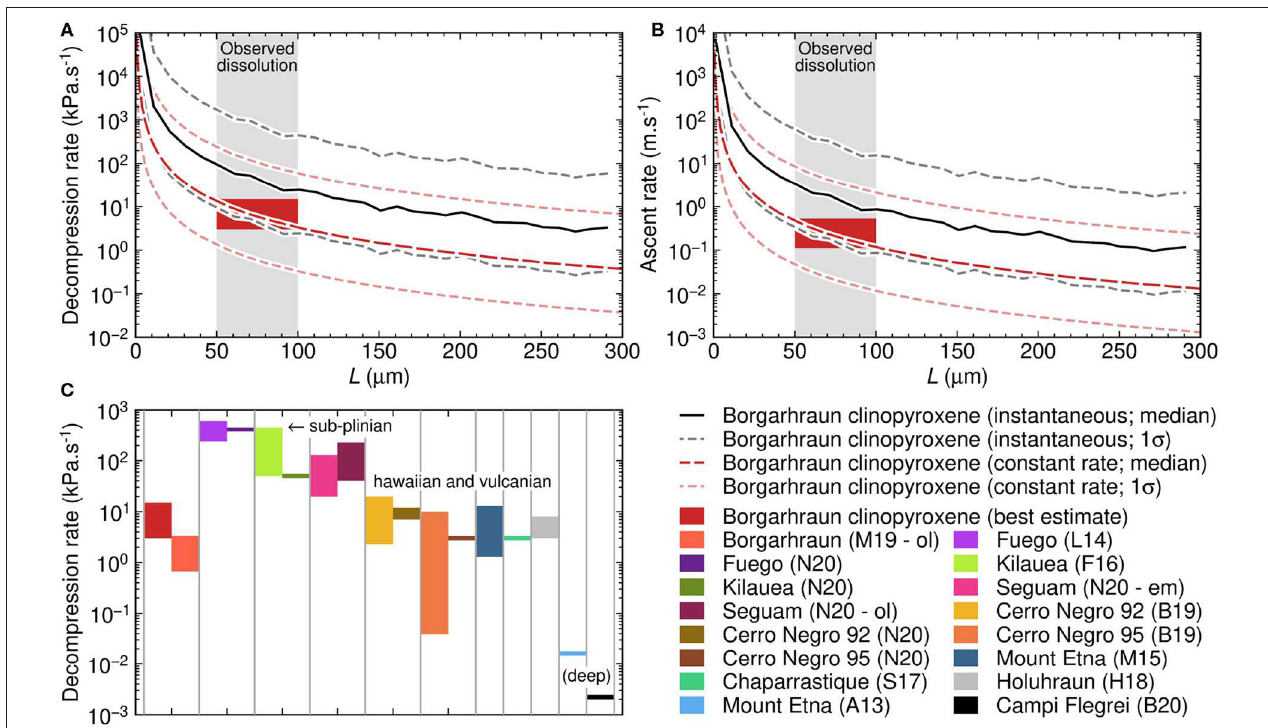
FIGURE 9 | Magma decompression and ascent rates in basaltic systems. (A,B) Magma decompression and ascent rates are shown as functions of dissolution length for nodule clinopyroxene cores dissolving into the Borgarhraun matrix glass in (A,B) , respectively. Solid black lines show decompression and ascent rates calculated using the dissolution times shown in Figure 8 . These decompression and ascent rates represent mean values calculated with the simplifying assumption that all dissolution took place at the surface following instantaneous ascent. Dashed red lines show decompression and ascent rates calculated assuming that magma decompression and ascent took place at a constant rate from onset of clinopyroxene dissolution. The vertical gray bar represents the range of dissolution lengths identified from QEMSCAN and BSE images ( Figures 2 , 3 ) that constrain our best estimates of magma decompression and ascent rates. (C) Literature estimates of magma decompression rate from basaltic systems compared with our best estimate for the Borgarhraun eruption. Methods and sources of decompression rate estimates are as follows: M19, olivine diffusion for the Borgarhraun eruption by Mutch et al. (2019b); L14, diffusive volatile loss from embayments for the 1974 eruption of Fuego by Lloyd et al. (2014); F16, diffusive volatile loss from embayments for various eruptions of K ¯ ılauea by Ferguson et al. (2016); N20, diffusive volatile loss from embayments for the 1977 eruption of Seguam (em), and diffusive H 2 O loss from olivine for episode 1 of the 1959 eruption of K ¯ ılauea Iki, the 1974 eruption of